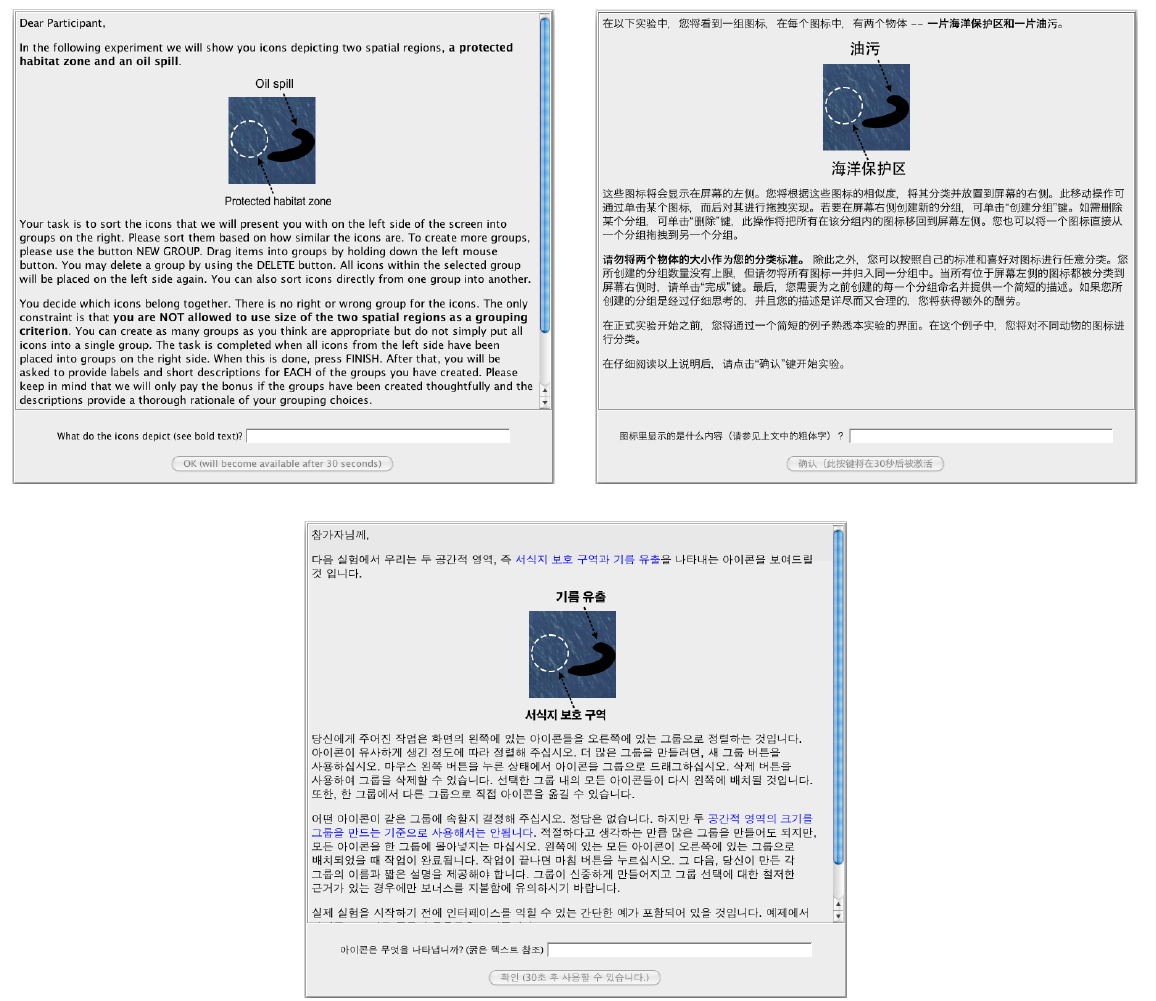
Figure 1: Screenshot of the three start screens of CatScan in three different languages (English, Chinese,